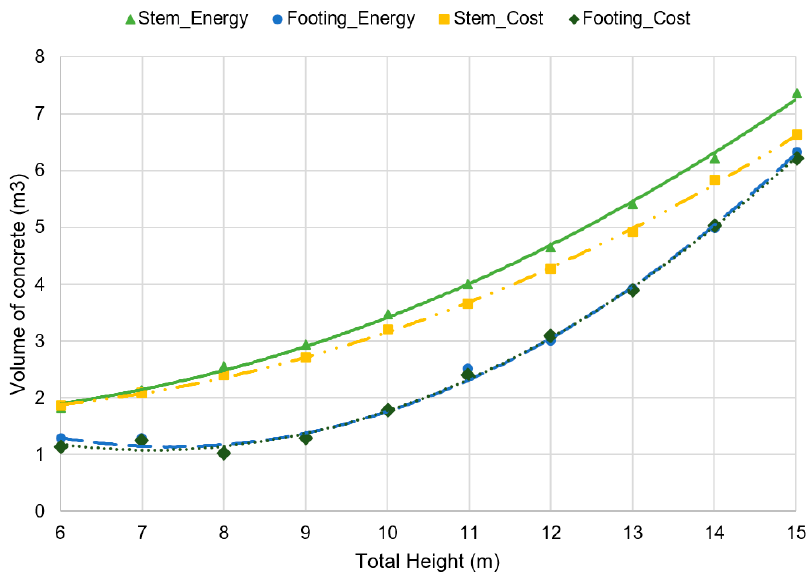
Figure 10. Relation between volume of concrete and wall